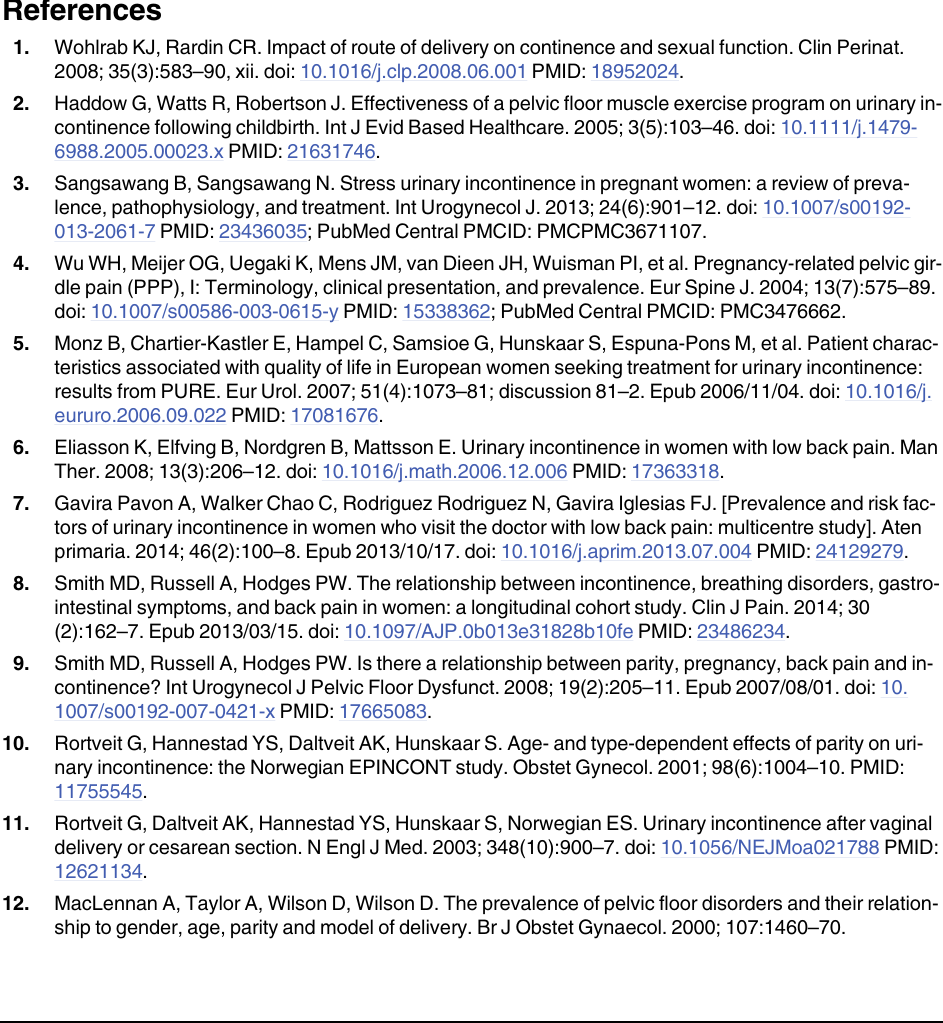
S1 Table. Demographic and obstetrical characteristics of women reporting symptoms of both back pain and urinary incontinence at 12 months